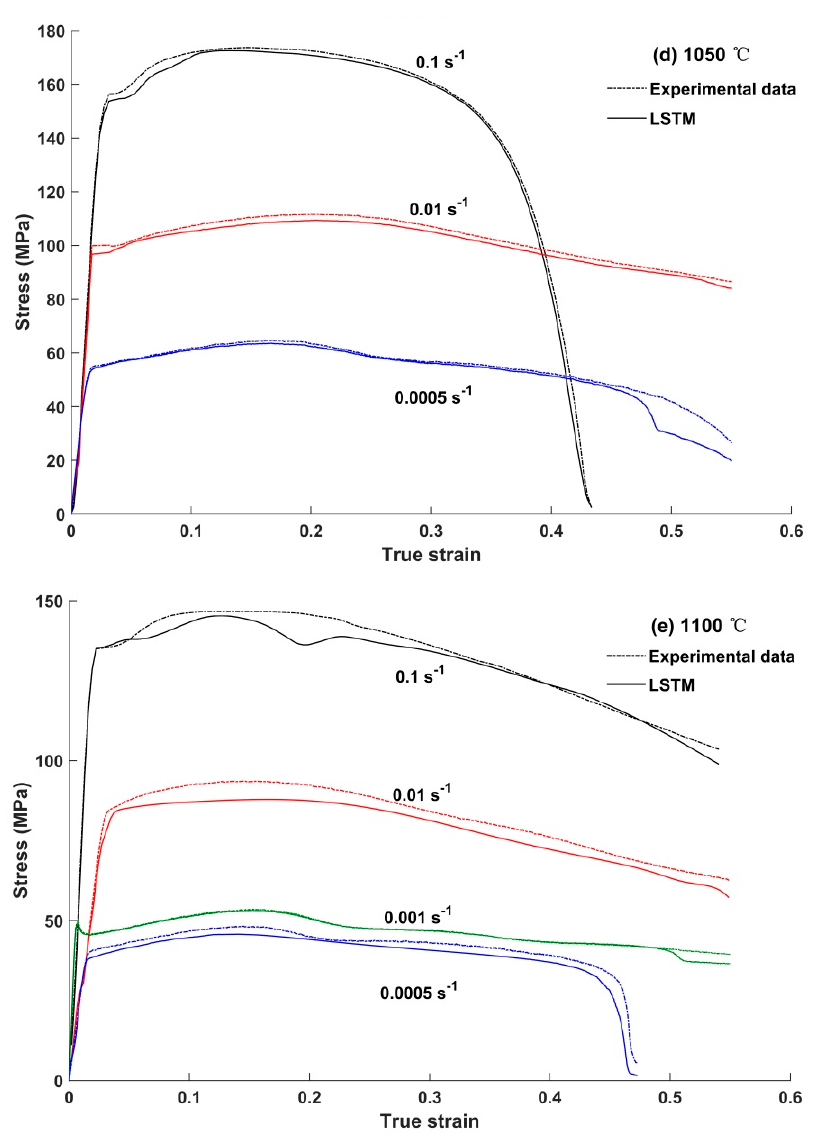
Figure 5. Fitting results of LSTM constitutive model. ( a ) 900 ◦ C; ( b ) 950 ◦ C; ( c ) 1000 ◦ C; ( d ) 1000 ◦ C; ( e ) 1100 ◦ C. Table 2. The correlation coe ffi cients between measured and predicted values. Deformation